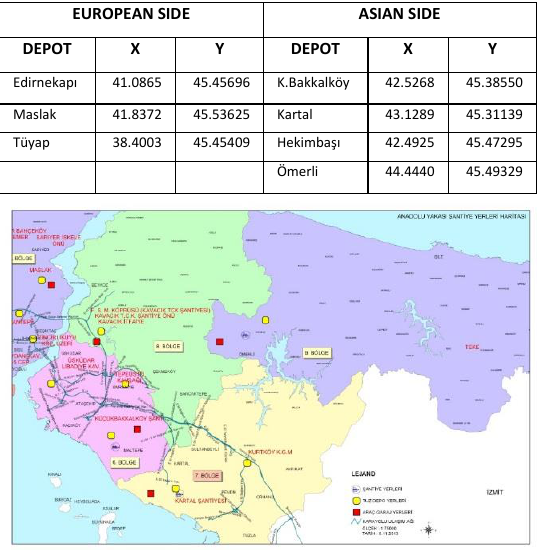
Table 1: Coordinates of The Depots